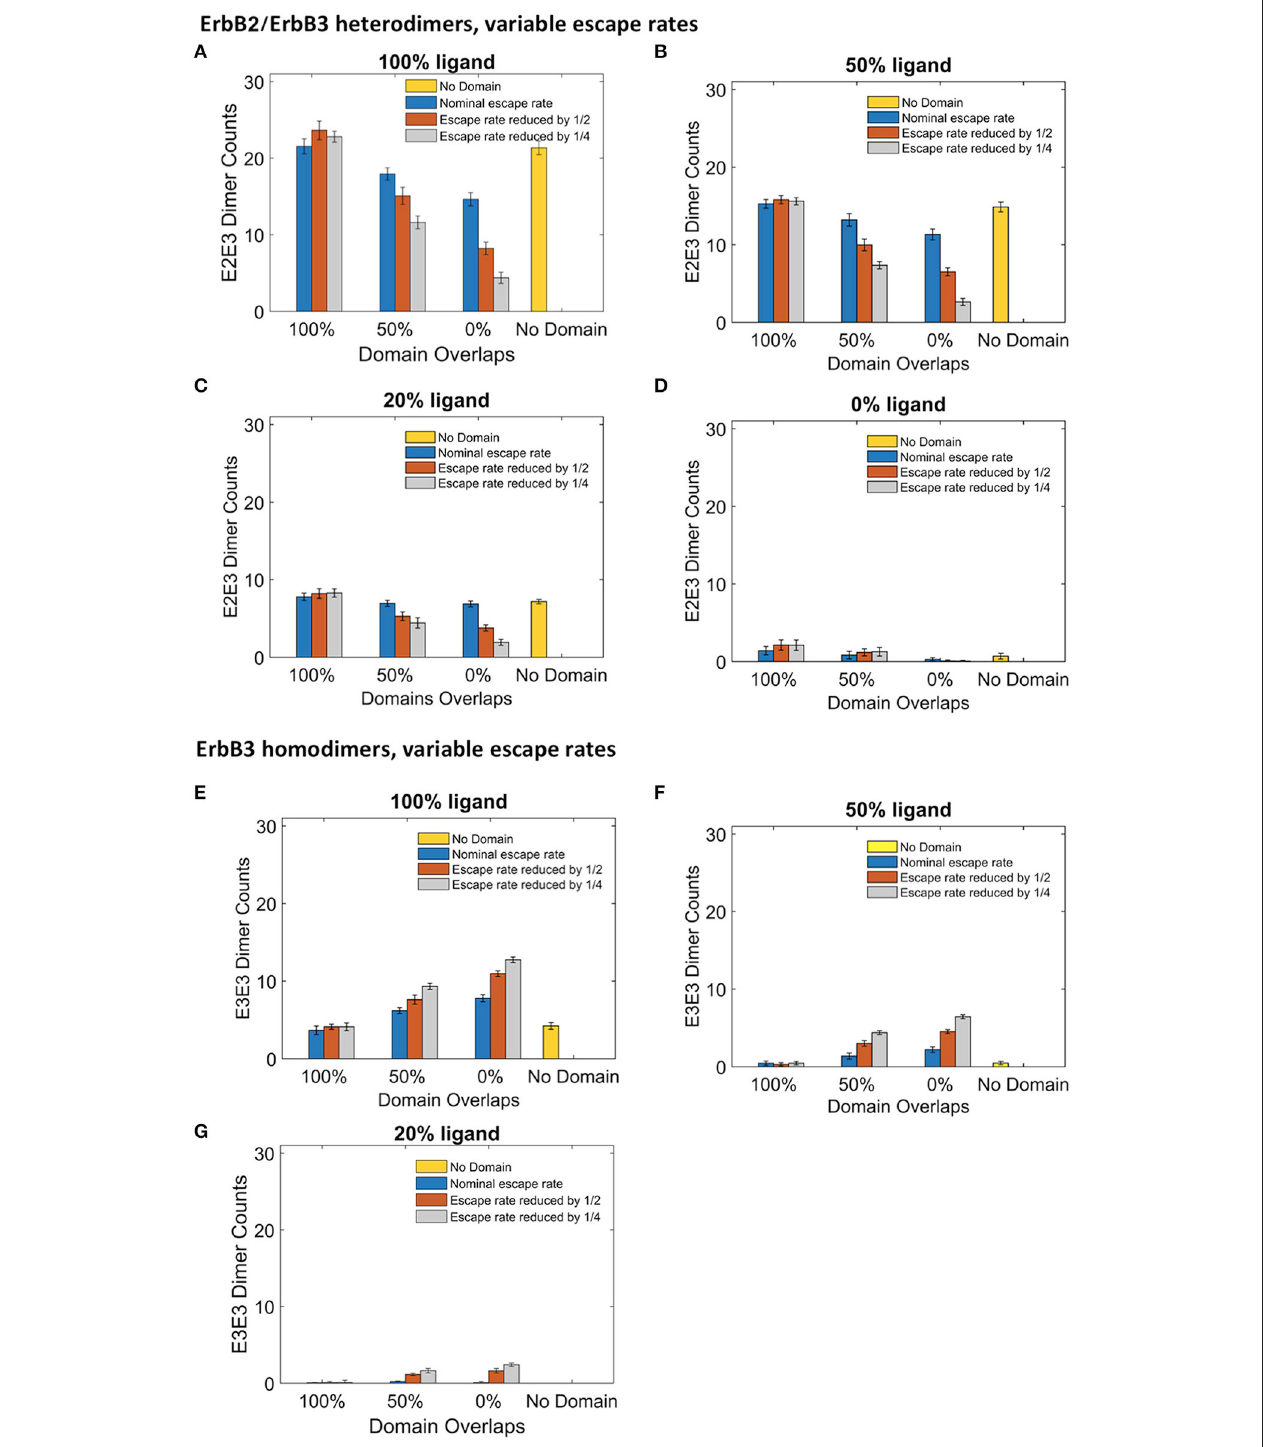
FIGURE 5 | The effect of changes in domain retention on ErbB2/3 heterodimer and ErbB3/3 homodimer counts across different ligand concentration and domains. Dimer counts across different membrane configurations, ligand concentration and three different escape rates- nominal escape rate (blue bars), escape rate reduced by ½ (orange bars), and escape rate reduced by ¼ (gray bars) as well as no domain simulations (yellow bars). (A) ErbB2/3 heterodimer for 100% liganded ErbB3. (B) ErbB2/3 heterodimer for 50% liganded ErbB3. (C) ErbB2/3 heterodimer for 20% liganded ErbB3. (D) ErbB2/3 heterodimer for 0% liganded ErbB3. (E) ErbB3/3 homodimer for 100% liganded ErbB3. (F) ErbB3/3 homodimer for 50% liganded ErbB3. (G) ErbB3/3 homodimer for 20% liganded ErbB3. The ErbB3/3 homodimer count was 0 for 0% liganded ErbB3. All bars are the averages of 4 runs ± standard deviation.